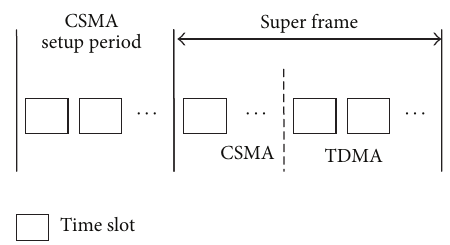
Figure 2: Dynamic routing mechanism with setup